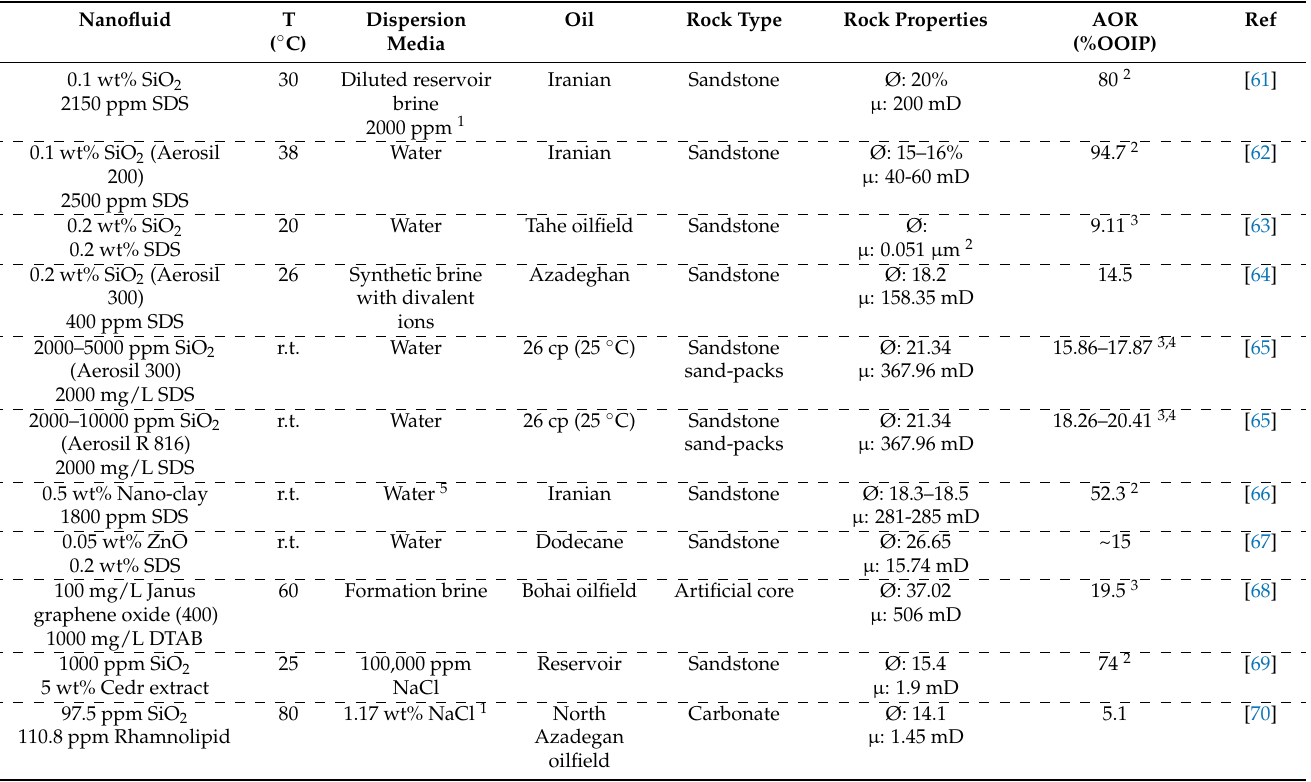
Table 4. Core-flooding tests involving nanoparticles and